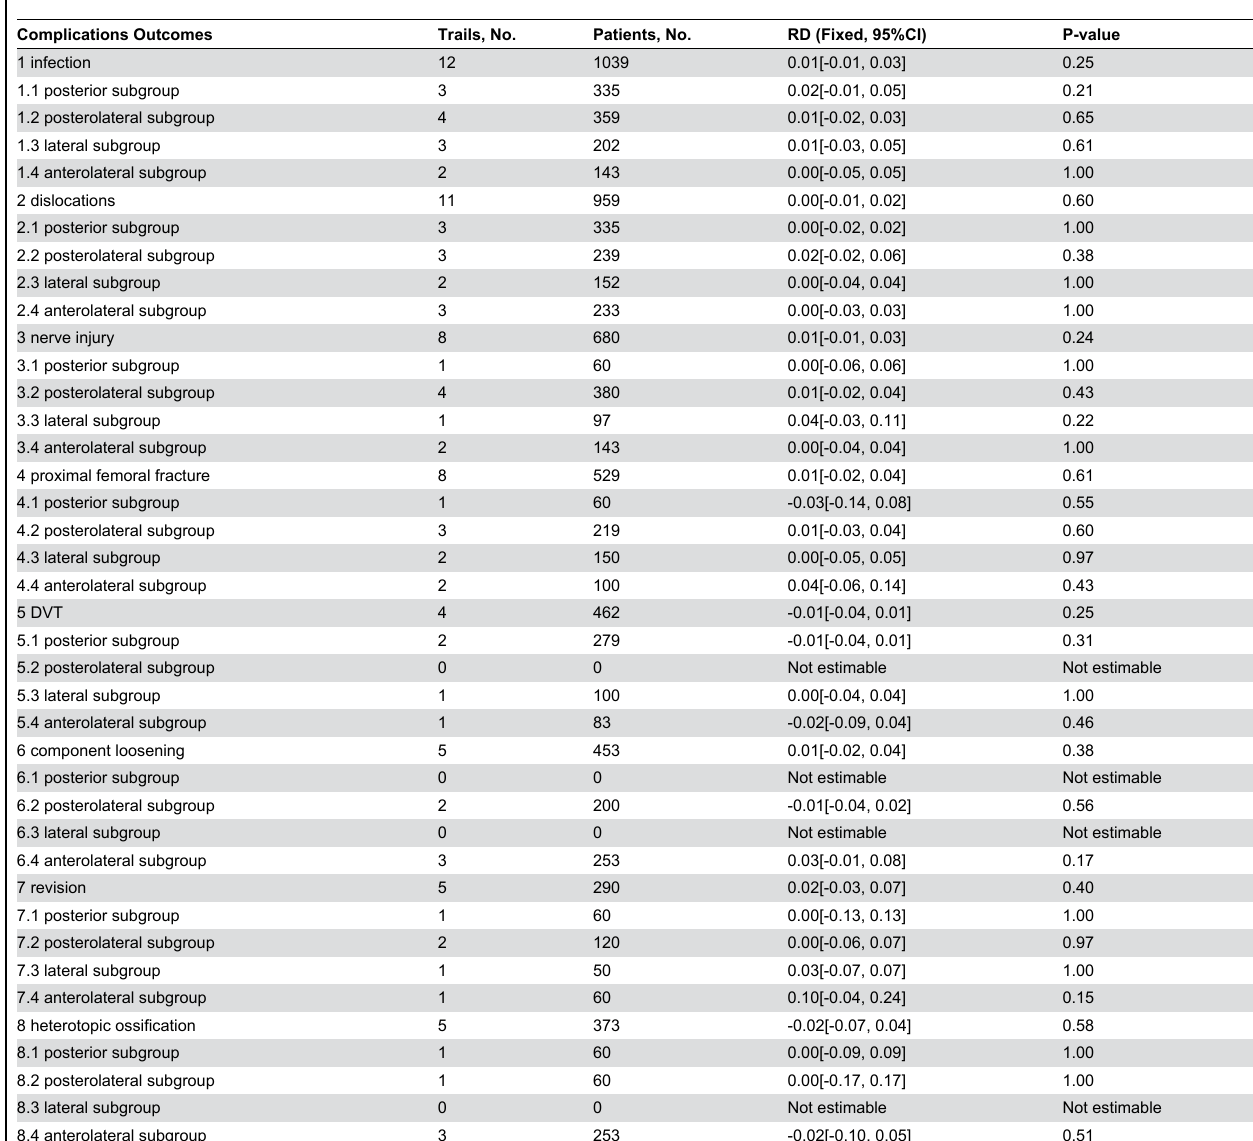
Table 3. Meta-analysis of randomized controlled trials evaluating complications